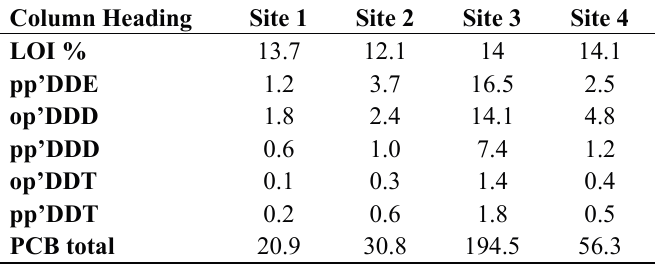
1. Concentrations (ng/g d.w.) of dichlorodiphenyldichloroethylene (DDE), p,p’-dichlorodiphenyldichloroethane (DDD), dichlorodiphenyltrichloroethane (DDT) polychlorobiphenyls (PCB) in sediment samples. Organic matter content is expressed as % of loss-on-ignition (LOI). Column